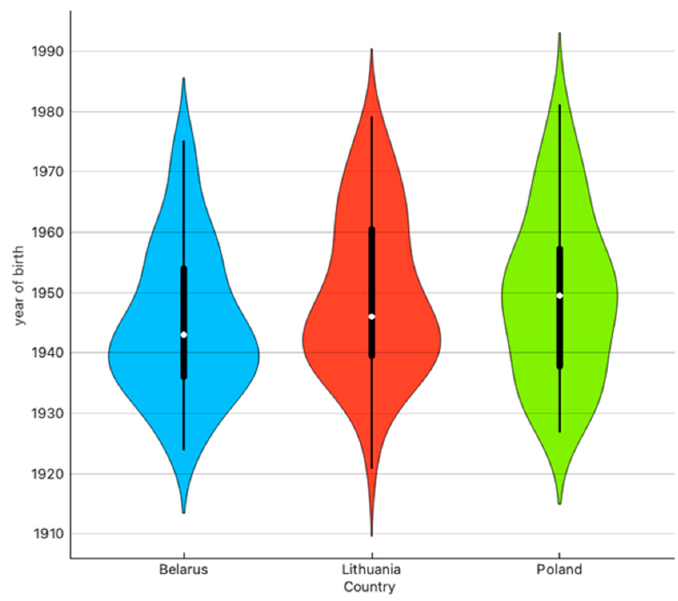
Figure 3. Violin plot of the age distribution of the sample in the three studied countries.